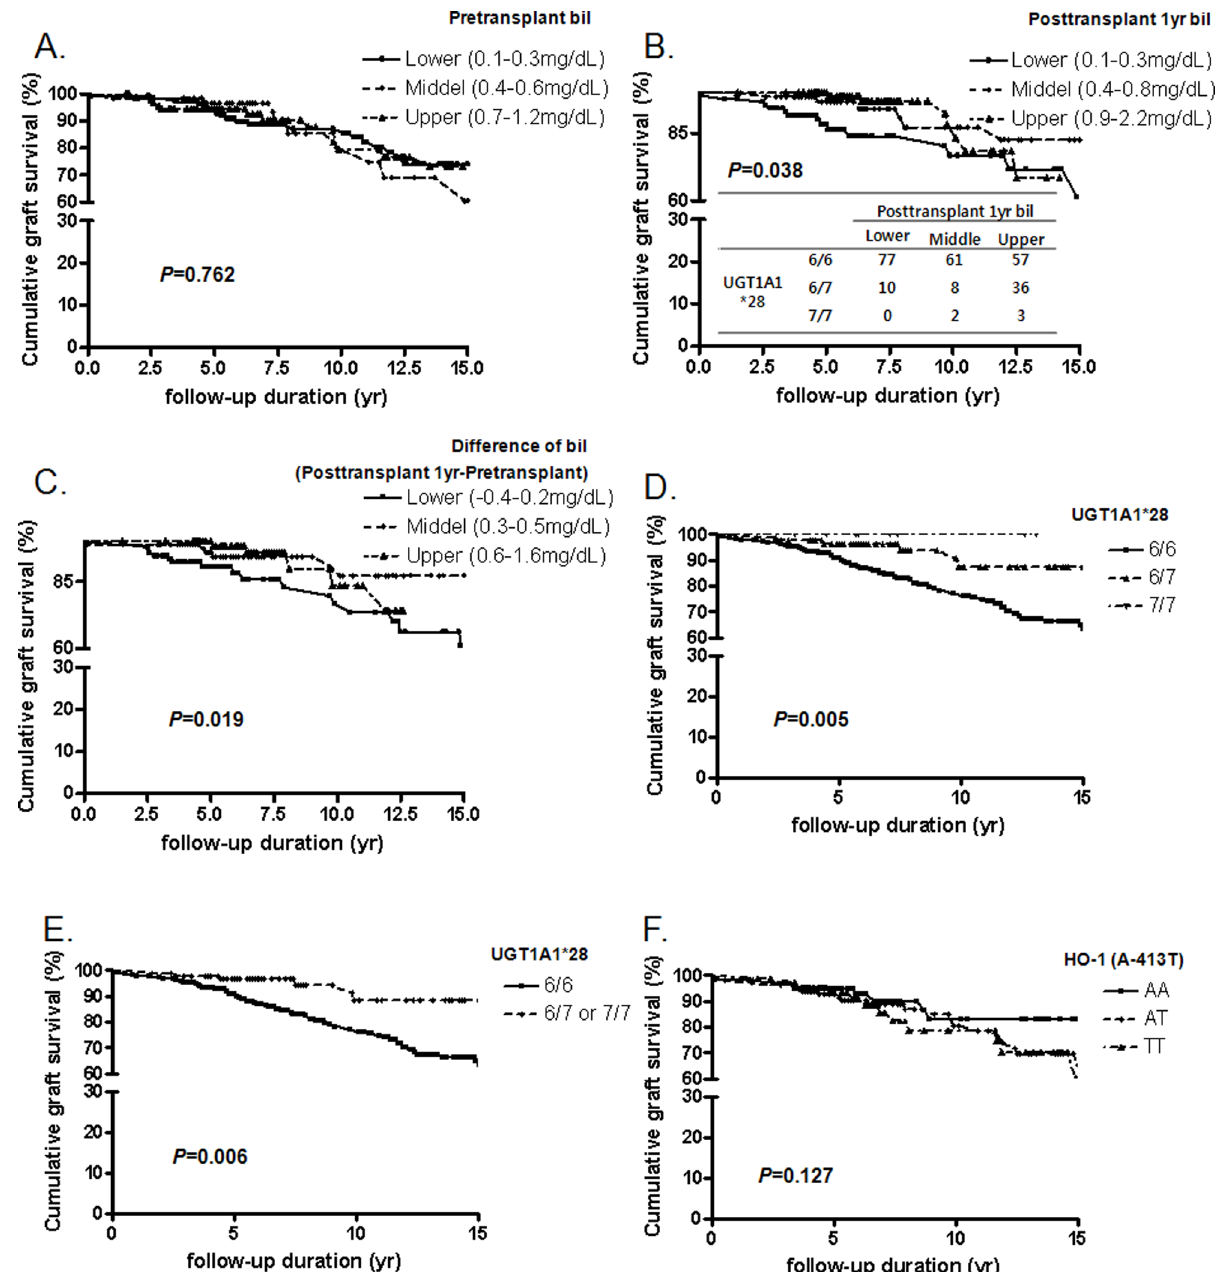
Figure 3. Long-term graft survival and sequence variations of HO-1 or UGT1A1*28. (A) Long-term graft survival according to pre- transplant serum bilirubin levels. (B) Post-transplant serum bilirubin levels. (C) Difference in total bilirubin values between pre-transplant and 1-year post-transplant. (D, E) UGT1A1*28 polymorphisms, and (F) HO-1 (A-413T) polymorphism.